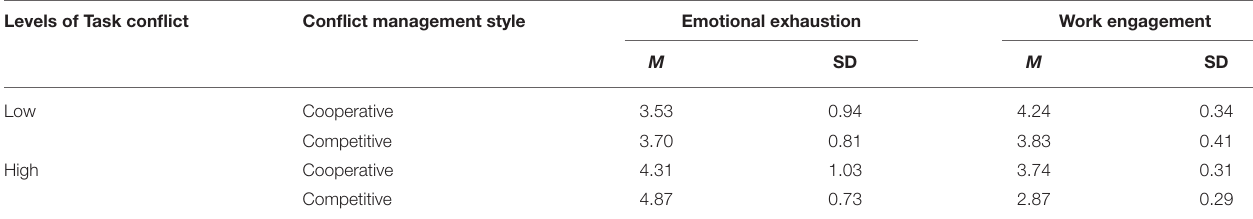
TABLE 7 | Descriptive statistics according to the conditions for work engagement and emotional exhaustion ( N =